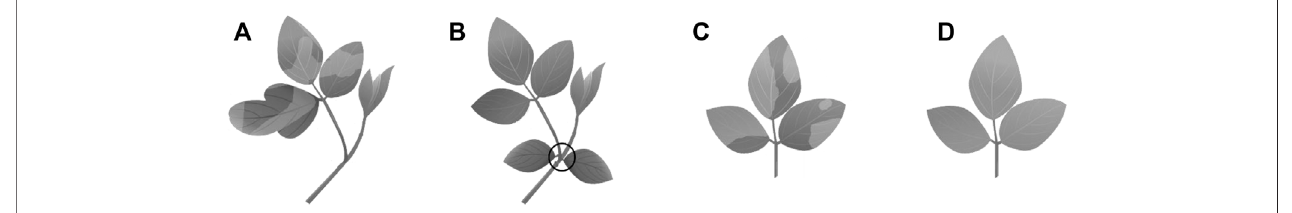
FIGURE 10 | Abnormal phenotypes of proton beam-irradiated soybean cultivars. (A) Abnormal leaf (239 Gy), (B) abnormal stem (117 Gy), (C) variegated leaf (365 Gy), (D) bright green leaf (239 Gy) (Im et al.,